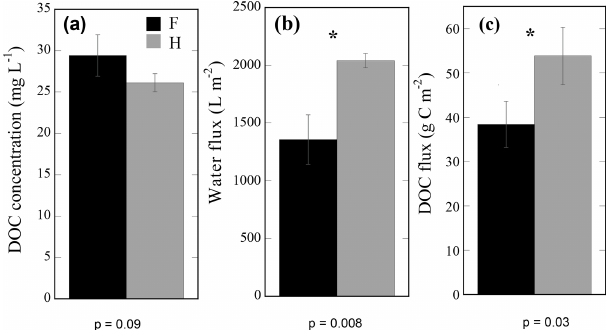
Figure 3. Mean annual lysimeter-collected variables. Volume- weighted dissolved organic carbon (DOC) concentration (a) , total water flux (b) , and total DOC flux collected from organic horizons of forest (F) and harvested (H) plots over the entire study period. Annual values were calculated from the accumulated 29 sample col- lection time points taken from 12 F and 12 H passive pan lysimeters over 1 year from July 2013 to July 2014. Asterisks show signifi- cant differences between plot type (alpha = 0.05), determined using one-way plot nested ANOVA tests (Table